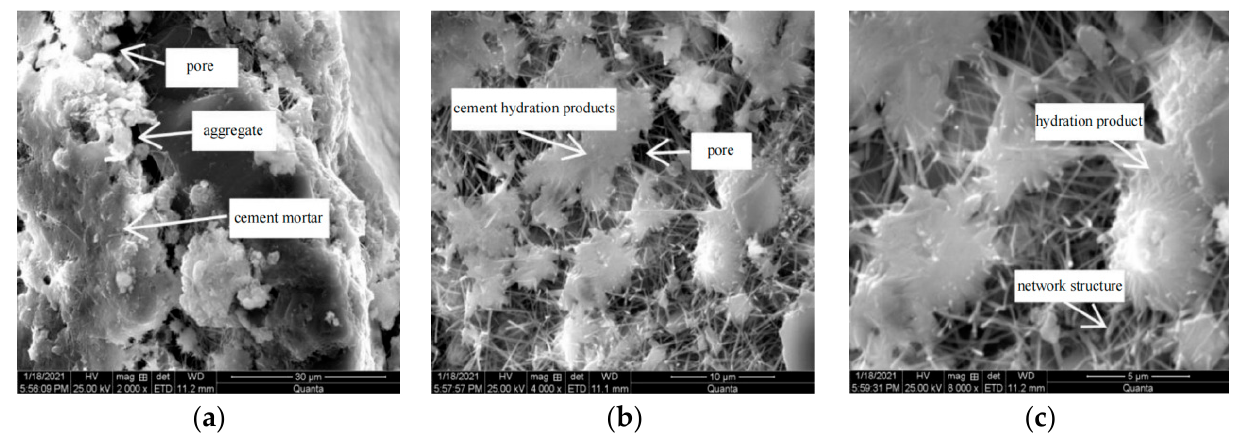
Figure 21. SEM images of R 0.5 C 0.09 specimens were magnified 2000 times ( a ), 4000 times ( b ), 8000 times ( c ), respectively.